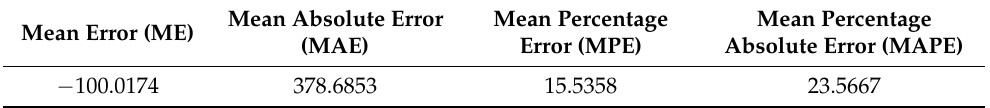
Table 2. Forecast errors. Source: own